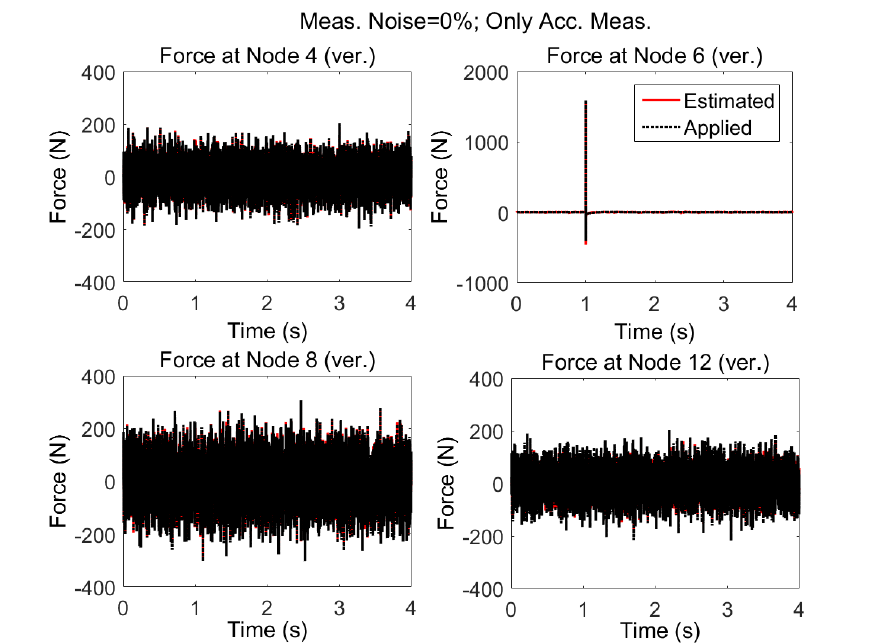
Figure 8. System is subjected to three uncorrelated random noise in vertical directions at nodes 4, 8, and 12 and impulse applied at node 6 (vertical). Excitations are estimated by AKF only using the accelerations; neither modeling nor measurement error is considered.